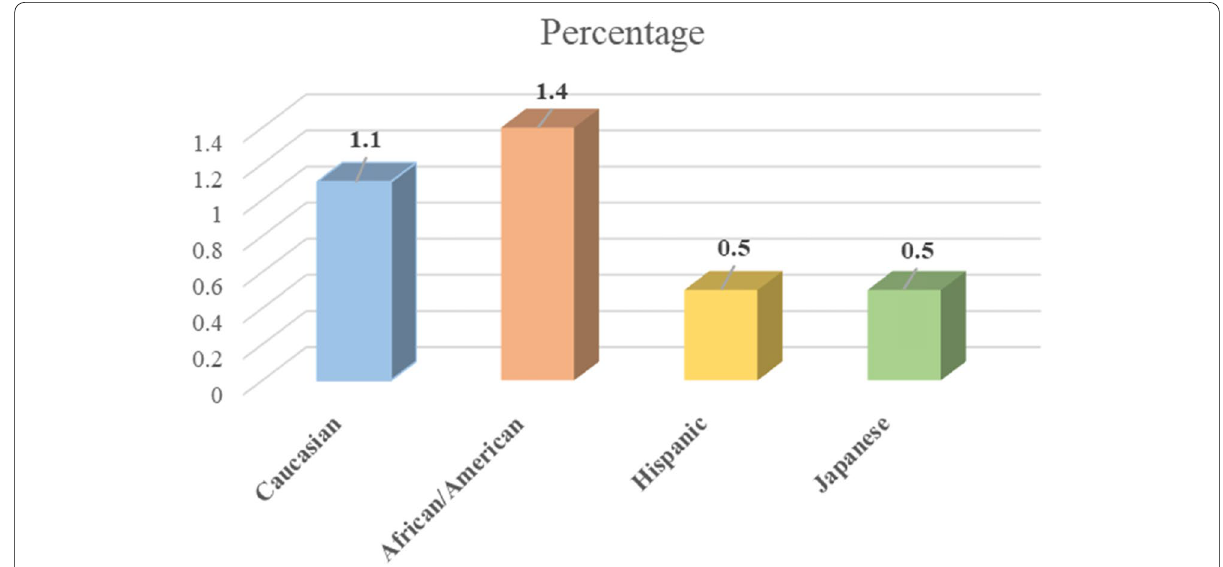
Fig. 1 Percentage of the global population affected by early